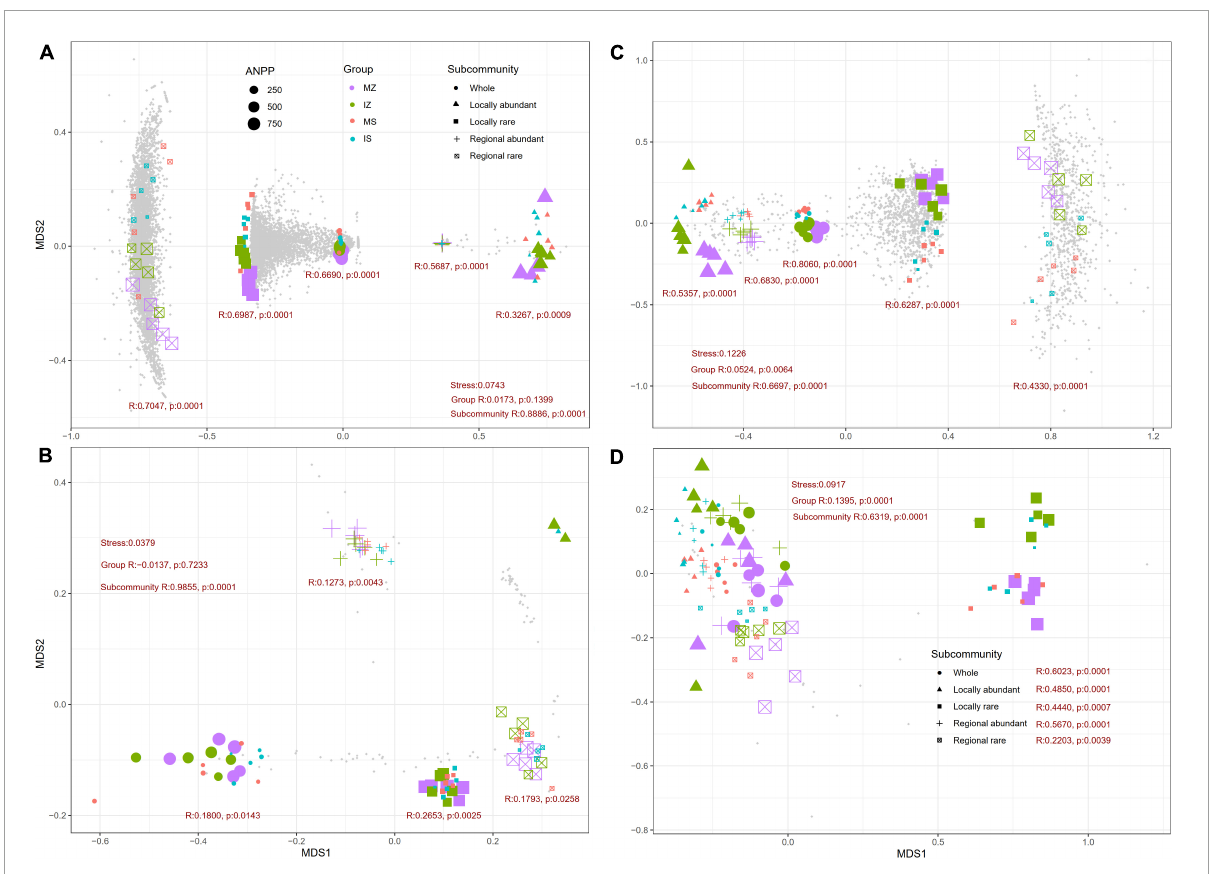
FIGURE5 Non-metric multidimensional scaling (NMDS) ordinations based on Bray–Curtis distance matrices of taxonomy (A,B) and functions (C,D) of bacterial (A,C) and fungal (B,D) subcommunities for all samples ( n = 20). A stress < 0.1 indicated that the result of NMDS is reliable. ANPP, aboveground net primary productivity; MZ, monoculture Zea mays ; IZ, intercropping Zea mays ; MS, monoculture Sophora davidii ; IZ, intercropping Sophora davidii . R and p were reported by ANOSIM.